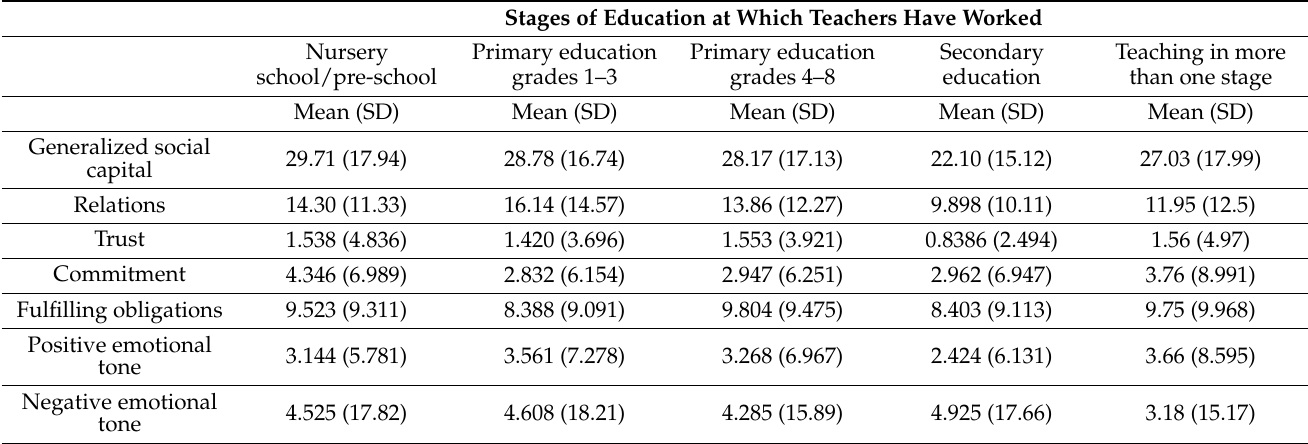
Table 4. Social capital and emotional tone of statements at different educational